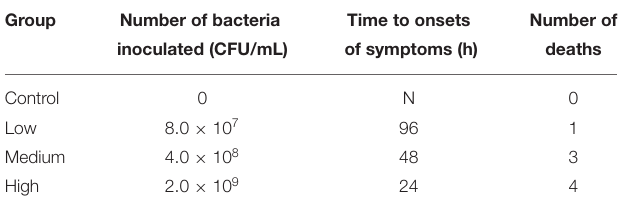
TABLE 3 | The time of clinical symptoms and the number of deaths after gavage of different doses. Group